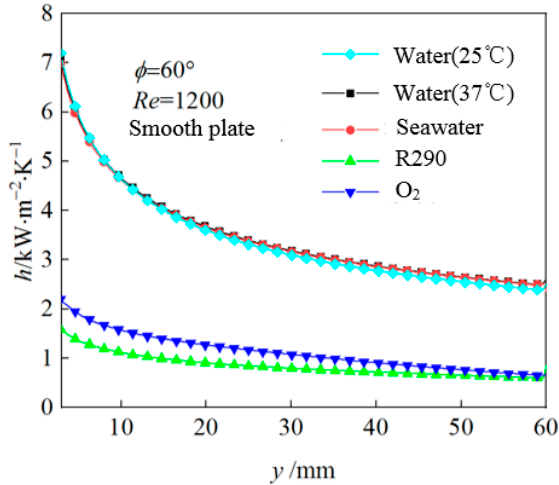
Figure 3. Local heat transfer coefficient h versus y for different fluids on the smooth plate.